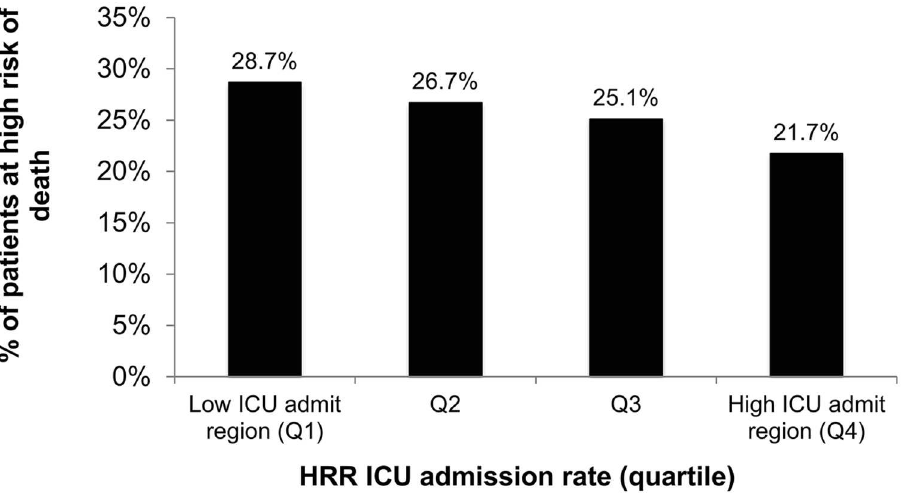
Fig 2. Fraction of patients at high-risk of death by strata of age-, sex-, race-adjusted HRR-levelICU admission. High risk of death definedas individualsin the top quartileof predictedrisk of